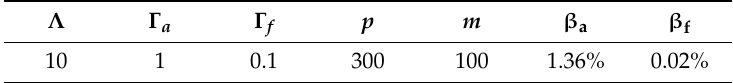
Table 2. DMC parameters of 1000 MW once through-type thermal power plant.